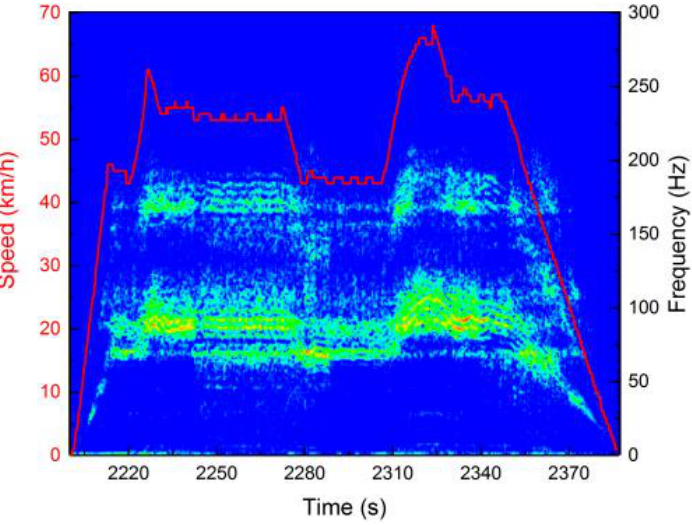
Figure 10. The speed-time-frequency relationship diagram at point D02.